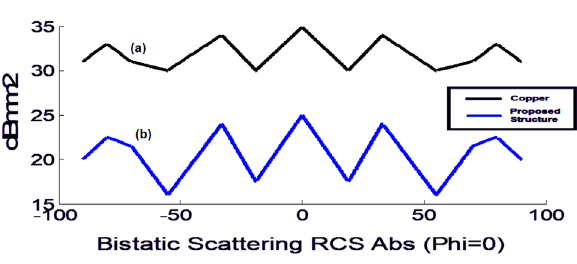
Figure 12. Curved structure ( a ) without and ( b ) with the proposed absorber.